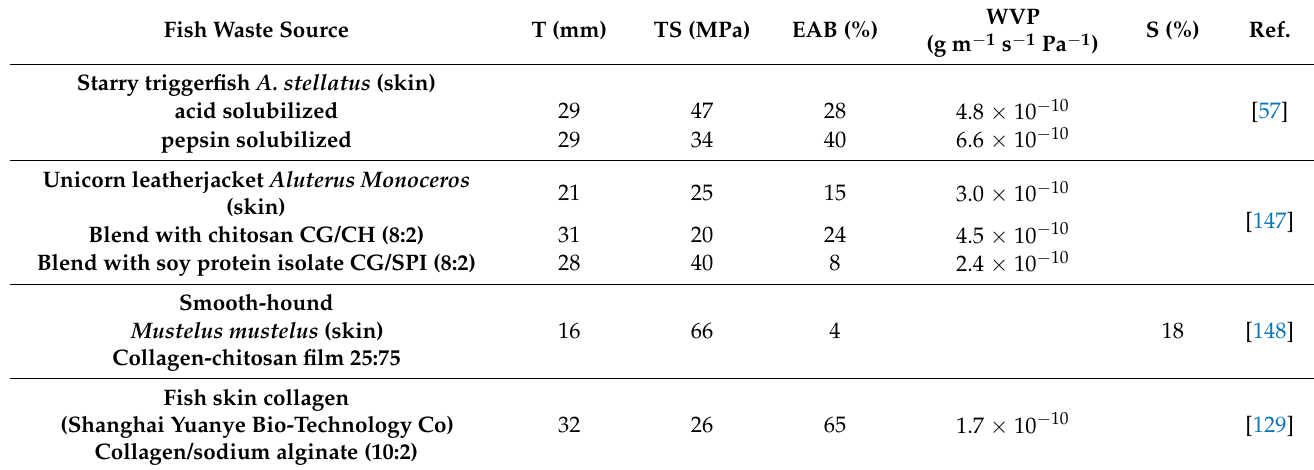
Table 2. Properties of bio-based and biodegradable polymer films derived from marine collagen. Fish Waste